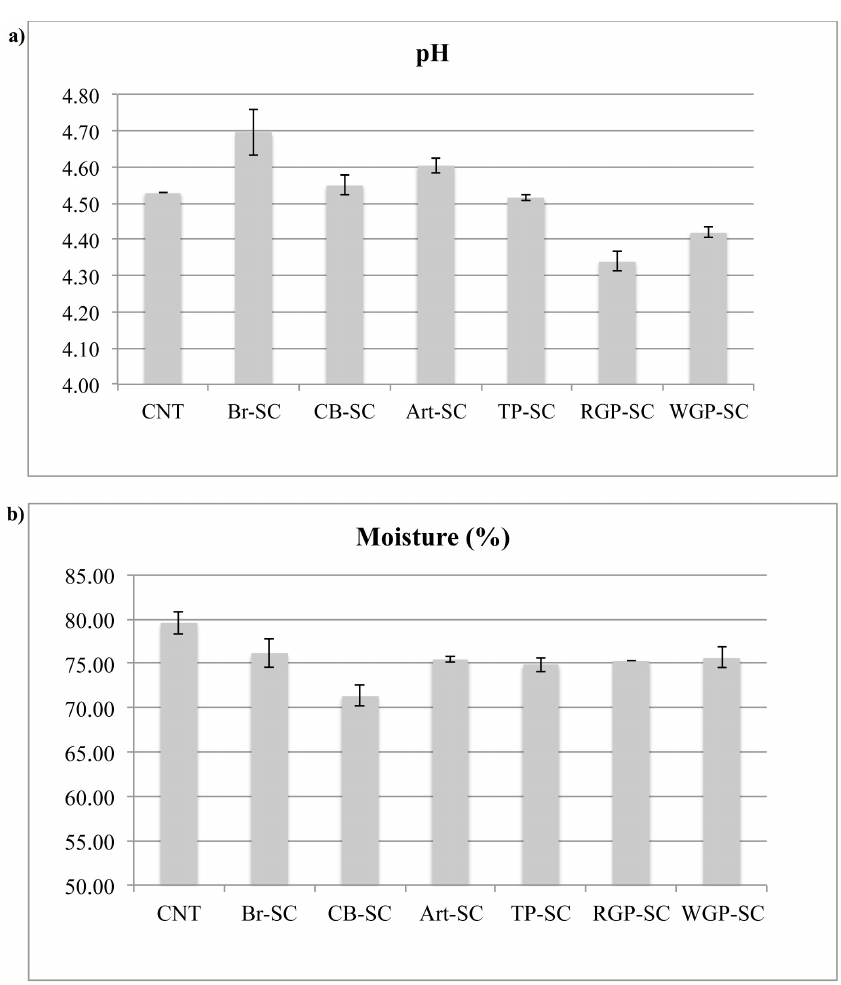
Figure 1. pH ( a ) and moisture content ( b ) of spreadable cheese enriched with different by-products.